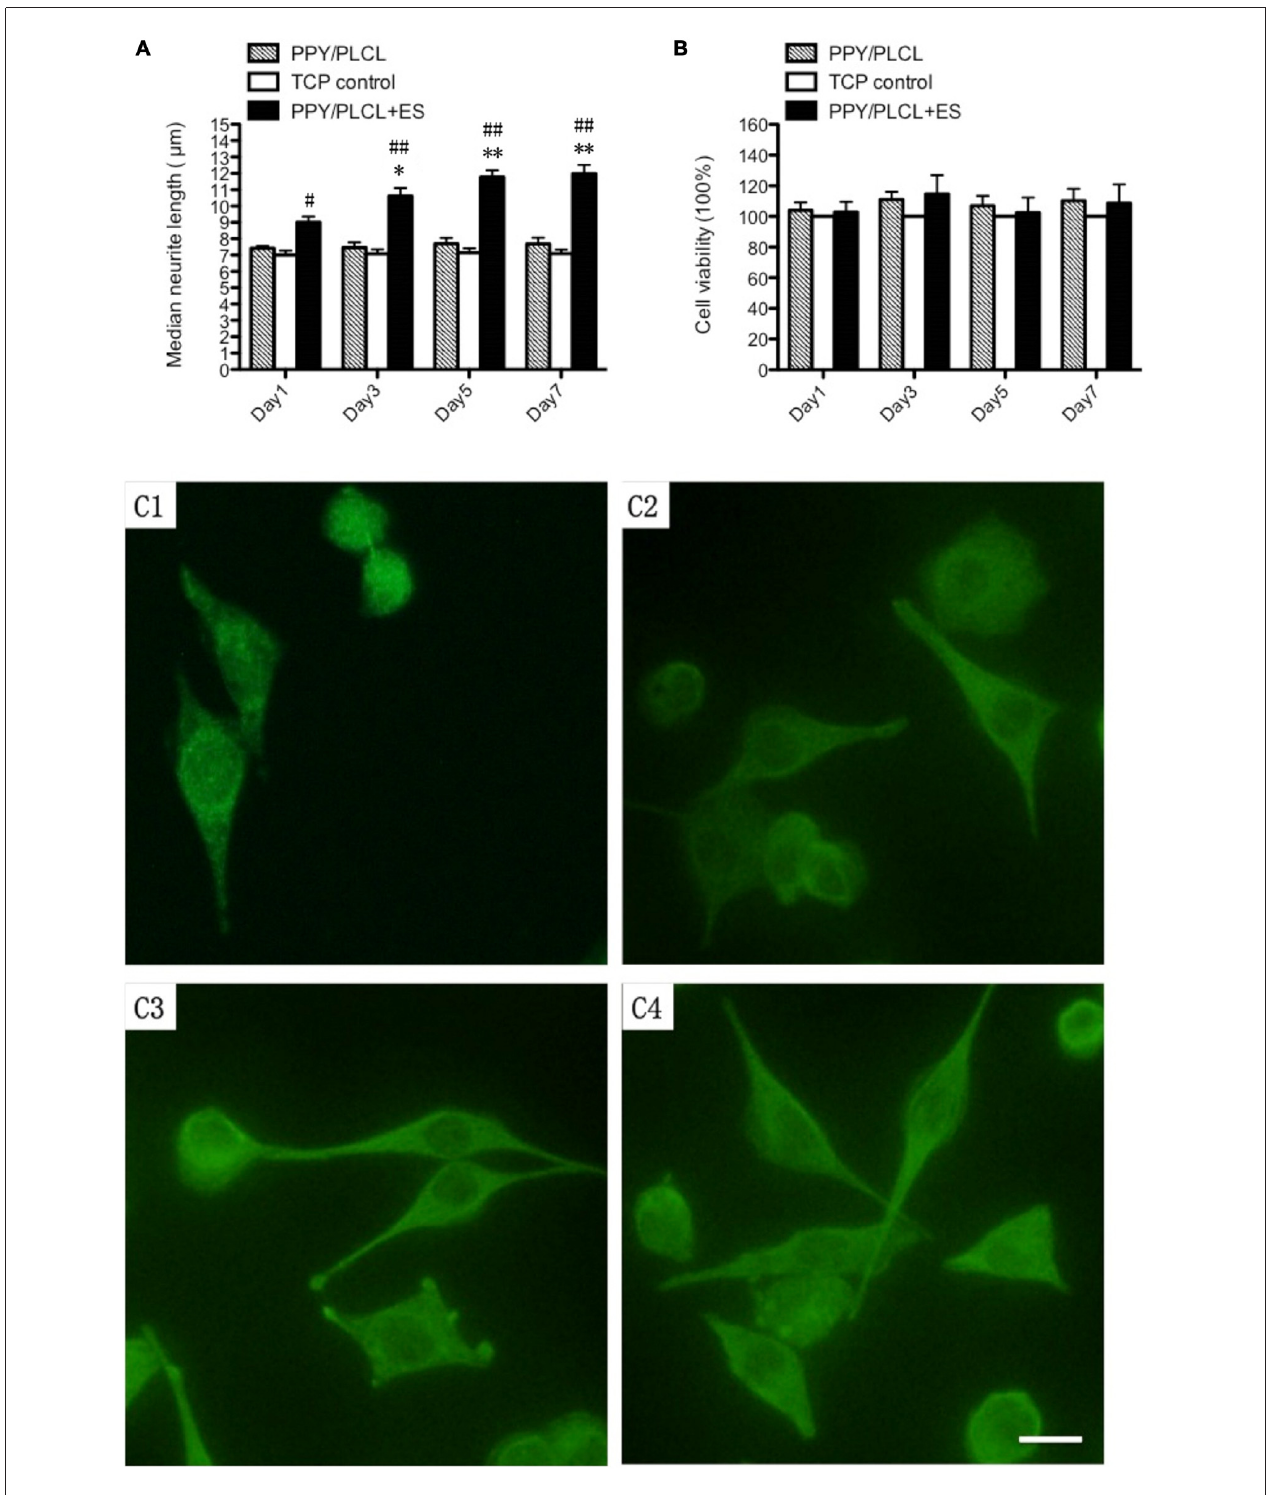
FIGURE 3 | In vitro study of pheochromocytoma (PC12) cells. (A) Median neurite length. (B) Cell viability by cell counting Kit-8 (CCK-8). All data from the tissue culture plates (TCP; control group), conductive PPY/PLCL film without electric stimulation (ES; PPY/PLCL group) and with ES (PPY/PLCL + ES group) on Day 1, 3, 5 and 7 ( n = 6, # p < 0.05, ## p < 0.01 the PPY/PLCL + ES group vs. TCP control group; ∗ p < 0.05, ∗∗ p < 0.01 the PPY/PLCL + ES group vs. PPY/PLCL group). (C) Fluorescence images of PC12 cells cultured on PPY/PLCL film with ES (E1: Day1, E2: day3, E3: Day 5, E4: Day 7; scale bar: 40 µ m).